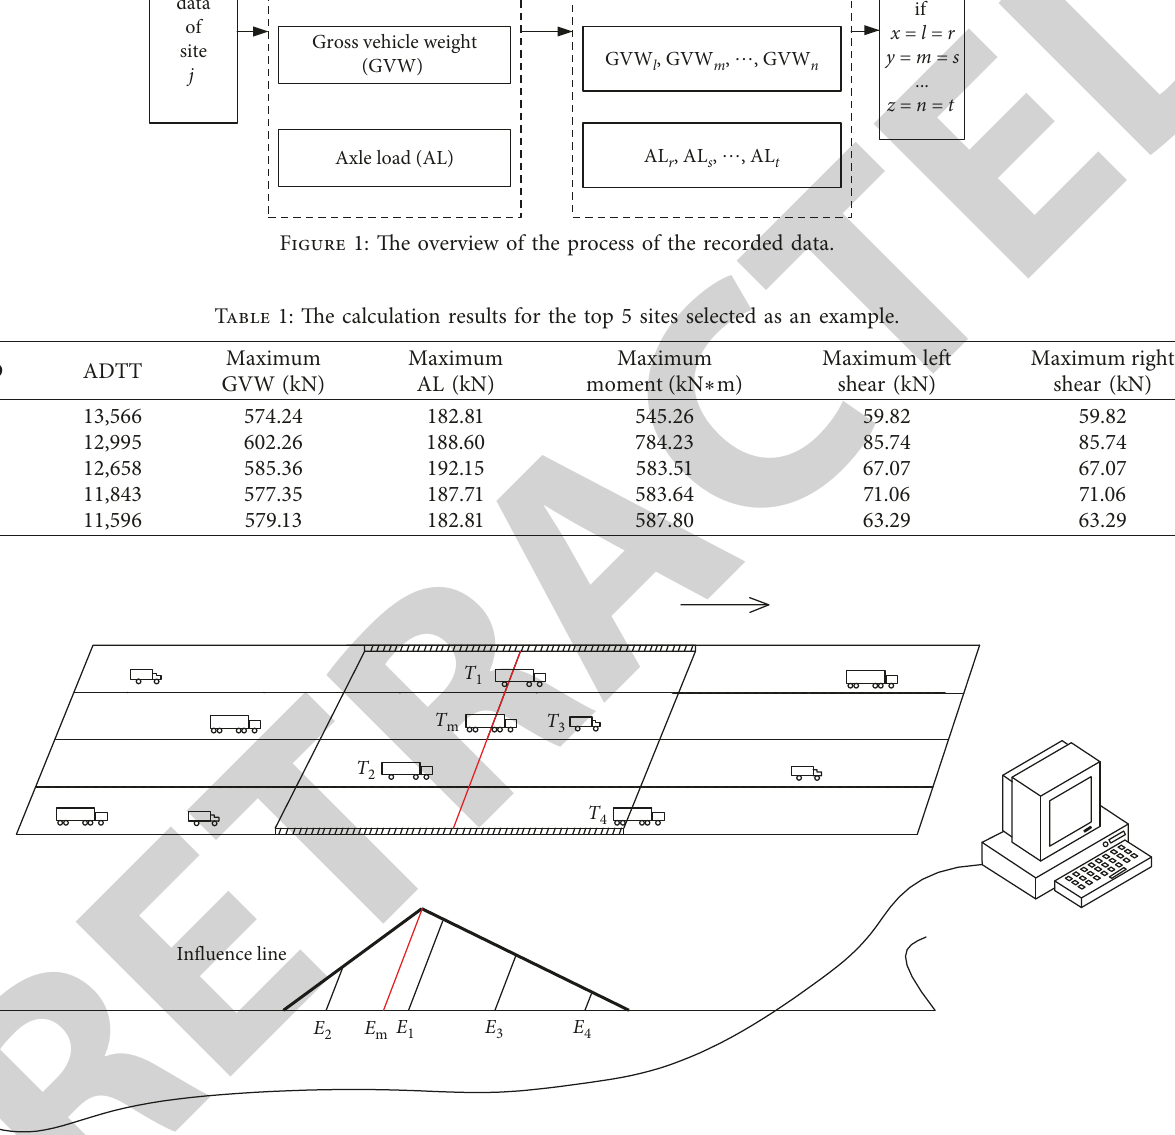
Figure 2: Illustration for computing load effect of midspan